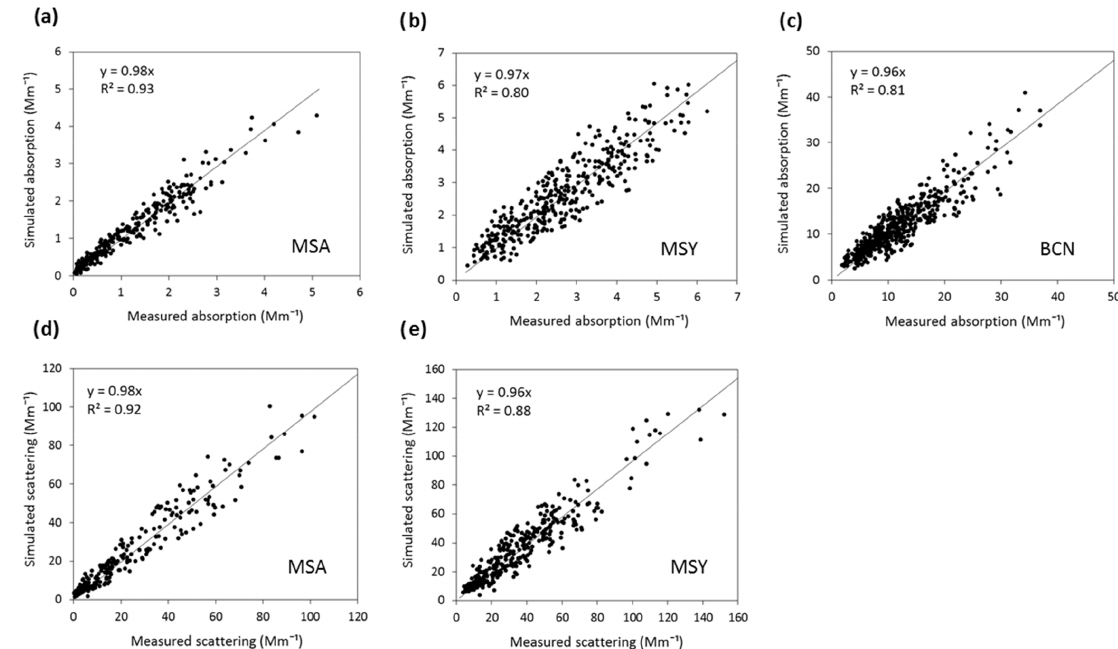
Figure 4. Relationship between modelled and measured optical parameters: absorption at 637nm for (a) MSA, (b) MSY and (c) BCN and scattering at 525nm ( d and e for MSA and MSY).